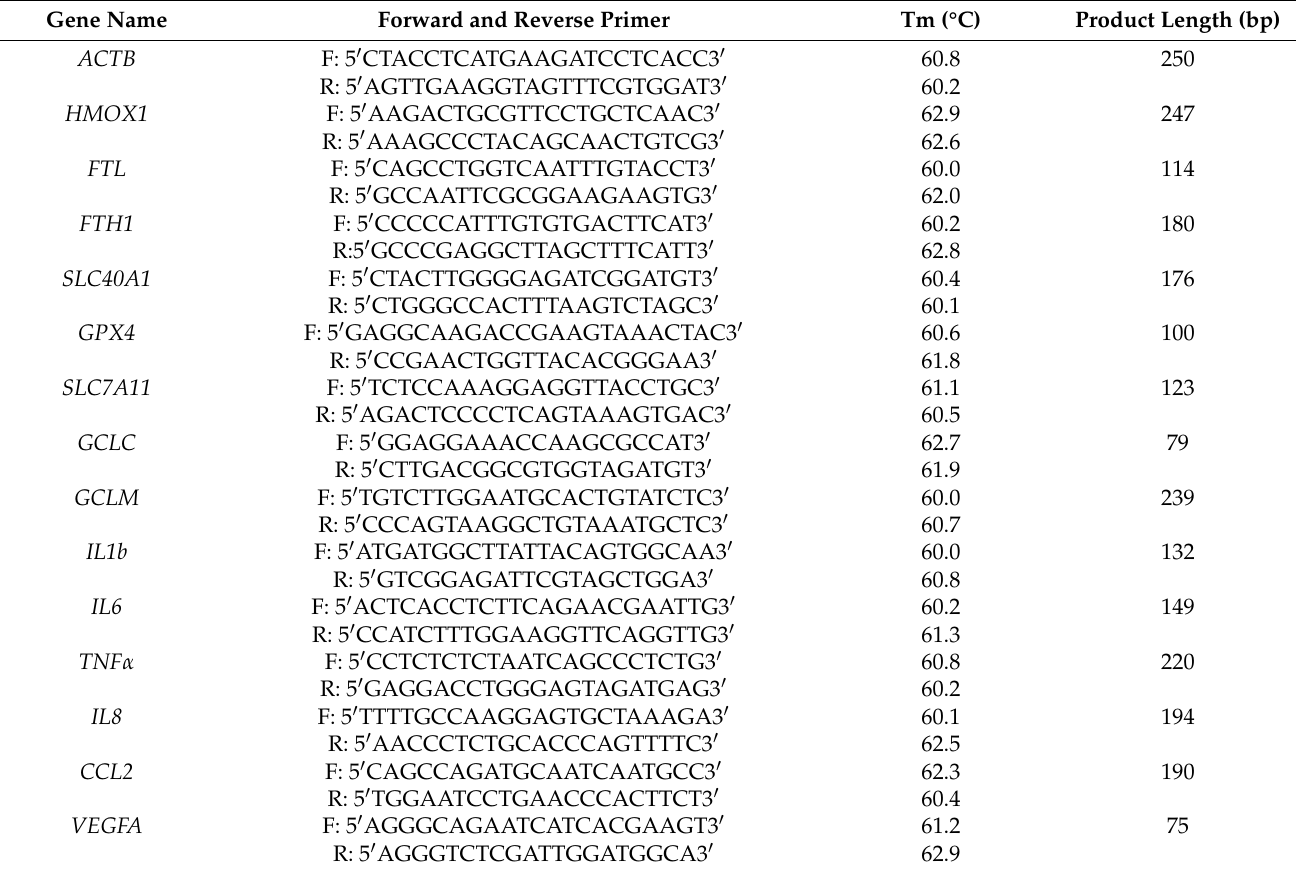
Table 2. The sequence of the primers for